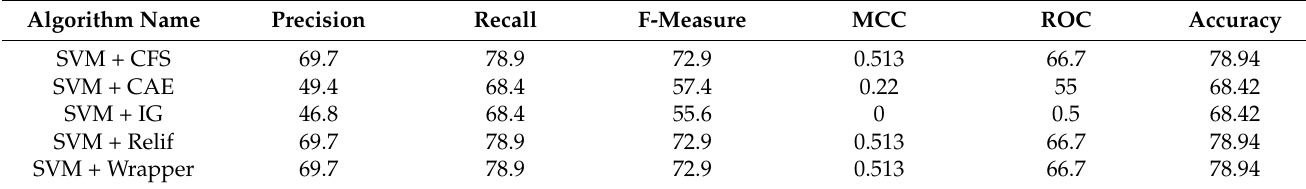
Table 16. Comparison among feature extraction algorithms using SVM classifier to predict the total